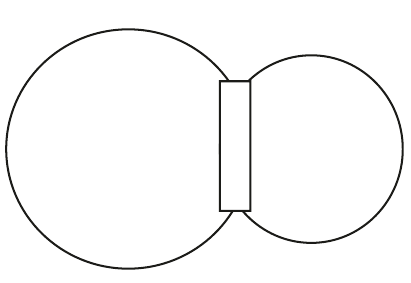
Figure 2: Parallel bond model